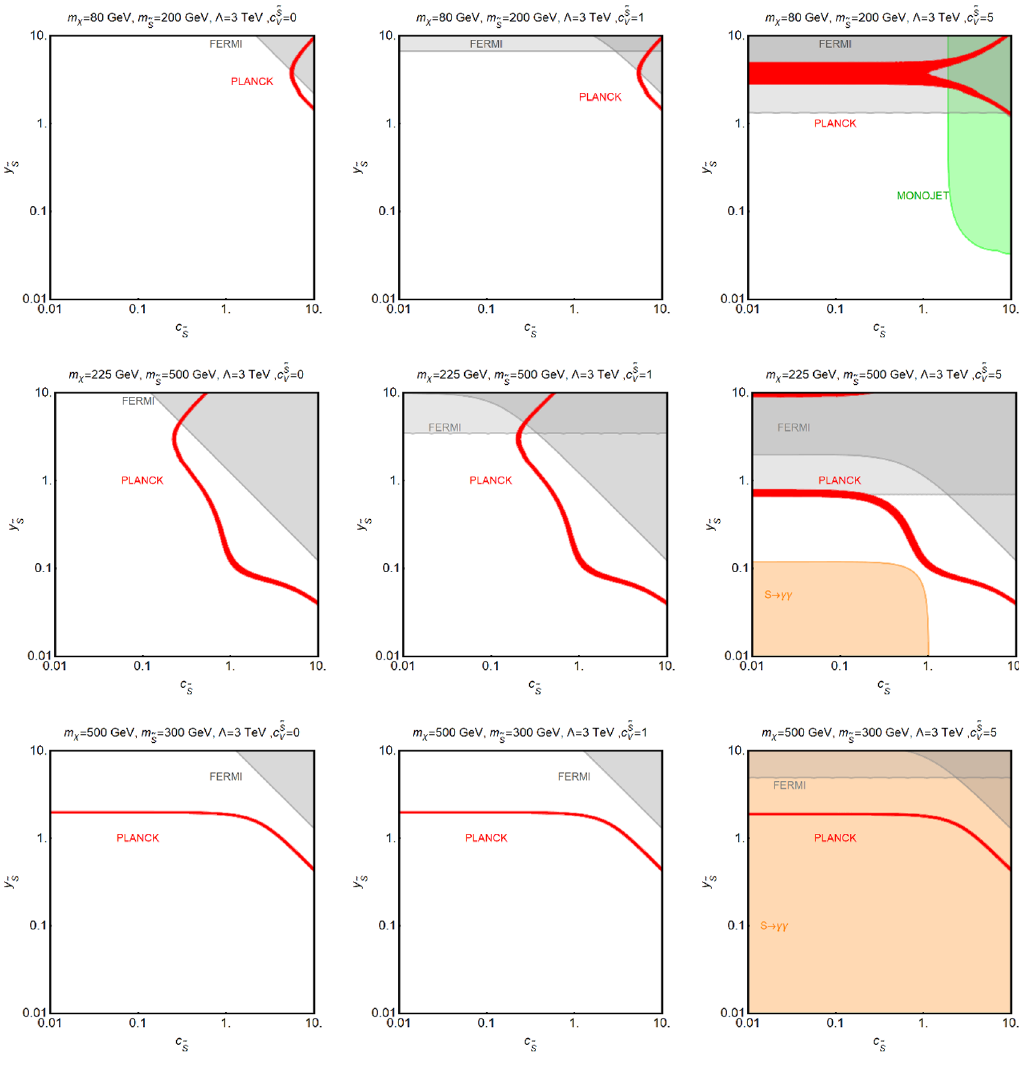
Figure 15 . Summary of constraints in the c ~ (cid:0) y ~ plane for c ~ S = 0 (left column), c ~ S = 1 (center V V S S column), and c ~ S = 5 (right column) and three di(cid:11)erent mass assignations as indicated in the V individual panels. The red contours correspond to the correct relic density while the gray regions are excluded by limits from ID. Orange regions are excluded by collider searches for resonances decaying into photons and green region by mono-jet